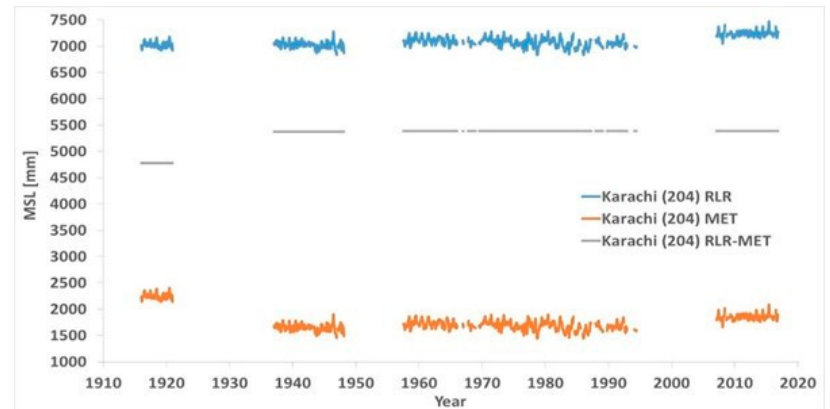
Figure 6. PSMSL RLR and MET data for Karachi, and their difference Delta RLR-Met. There are four segments, with three offsets to verify.